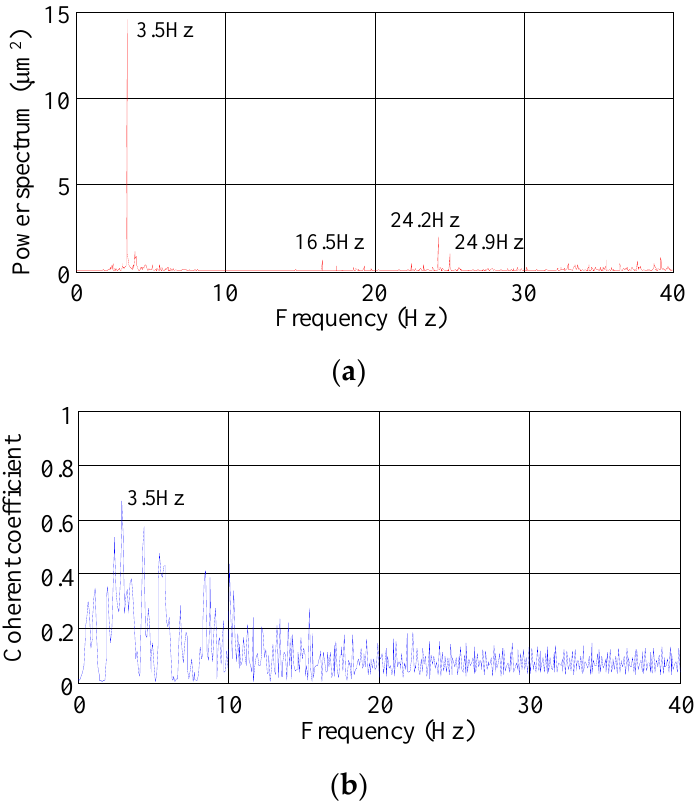
Figure 15. MP-FRF ( a ) and coherence coefficient ( b ) between the signal at orifice and T9.